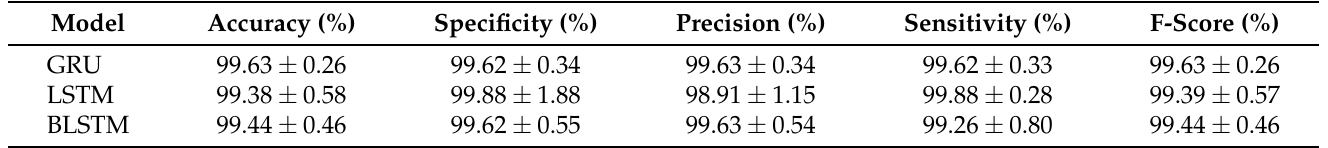
Table 9. The classification performance obtained using the RNN-based classifiers with the hold out CV approach for the automated classification of the BFMAC vs. DMAC